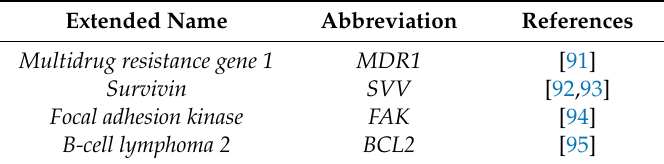
Table 4. Molecular targets implicated in drug